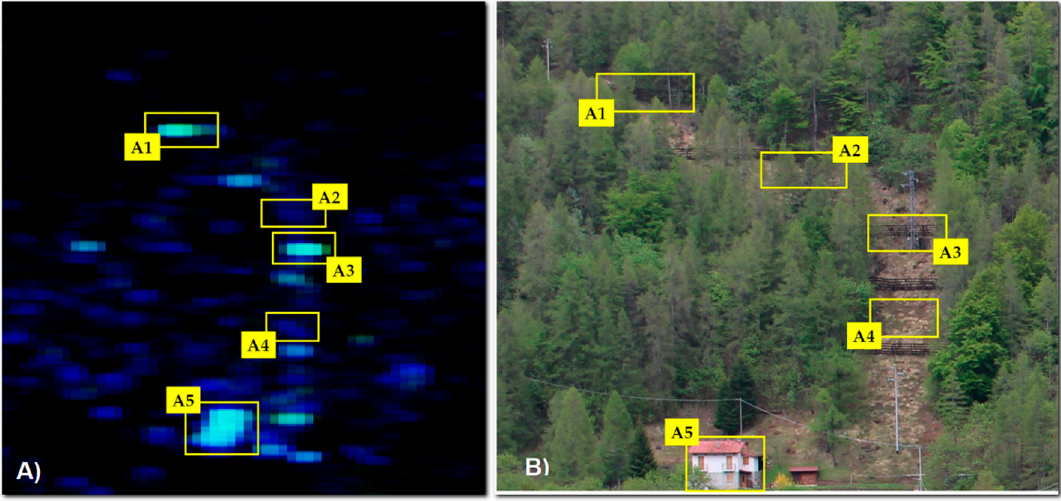
targets. ( B ) Corresponding picture of the zoomed area.